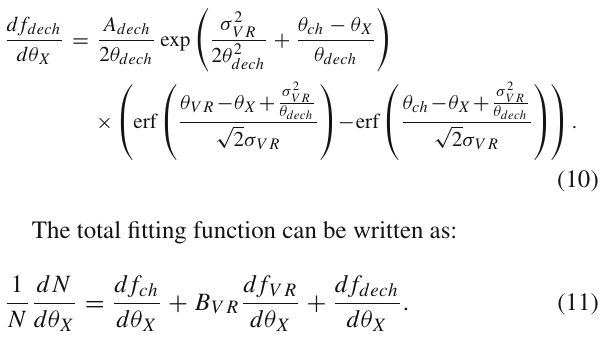
Fig. 3 Experimental ( a , c ) and simulated ( b , d ) angular scans. Deflec- tion angle vs. the crystal-to-beam orientation of Si ( a , b ) and Ge ( c , d ) crystals, bent at 315 µ rad and 820 µ rad respectively. Vertical white